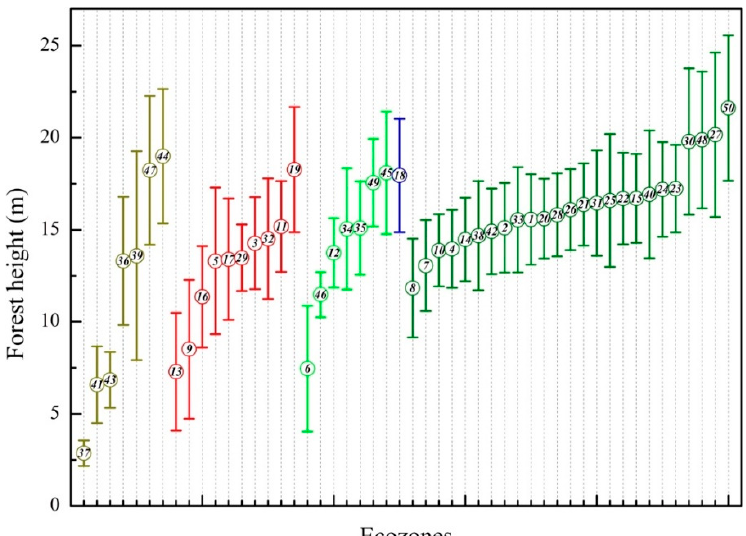
Figure 7. Distribution of forest heights from remote-sensing data in 50 ecozones. Colors indicate different ecozones: dark yellow areas are desert, red are agricultural areas, light green areas are grassland, olive areas are forests, and blue areas represent a special ecozone in the Three Gorges Reservoir. Numbers in circle represent different ecozones, and the bar represents the standard deviation. The statistical information of forest height in 50 ecozones is listed in supplement Table S2.